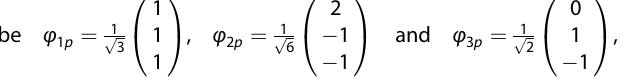
Table 1. We fi nd that the CS-II (36.7% e g , 63.3% t 2g ) owns more e g orbital components and less t